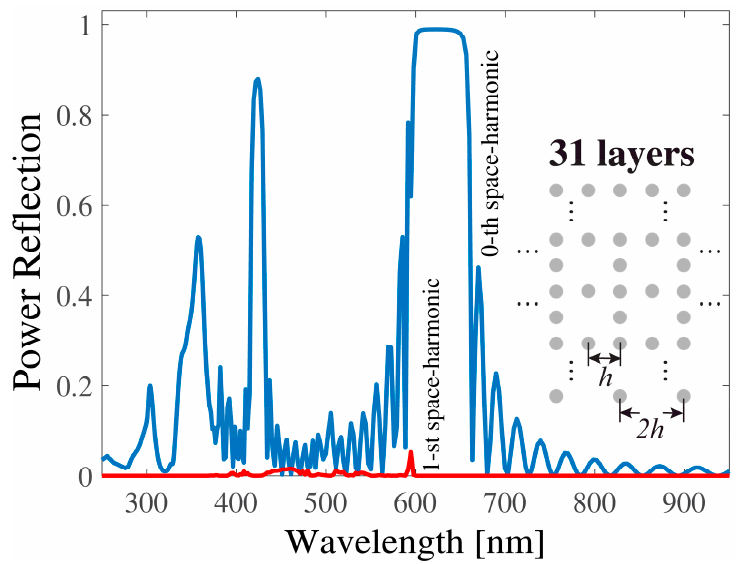
Figure 3. The same settings as in Figure 1, but the crystal was formed by alternately stacking the complete layer with a period h and the defect layer, where one nanocylinder was periodically removed according to the period 2h .